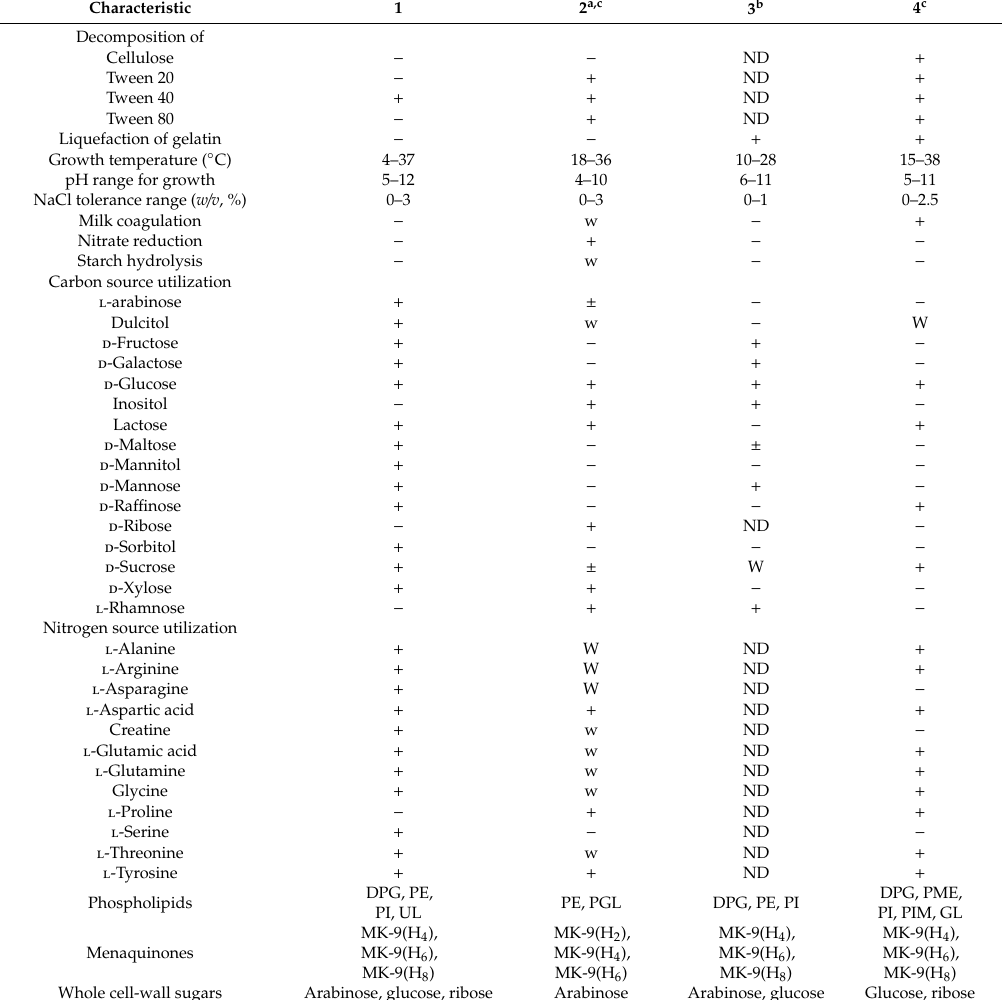
Arabinose Arabinose, glucose Glucose, ribose Strains: 1, NEAU-wh3-1; 2, Embleya scabrispora DSM 41855 T ; 3, Embleya hyalina MB891-A1 T ; 4, Streptomyces lasii 5H-CA11 T . Abbreviation: + , positive; –, negative; ± , ambiguous; ND, not determined; w, weak; DPG, diphosphatidylglycerol; PME, phosphatidylmonomethylethanolamine; PE, phosphatidylethanolamine; PI, phosphatidylinositol; PIM, phosphatidylinositolmannoside; UL, unidentified lipid; GL, glucosamine-containing lipid; PGL, phospholipid containing glucosamine. All data are from this study except where marked. a Data from Ping et al. [43]; b Data from Komaki et al. [41]; c Data from Liu et al.